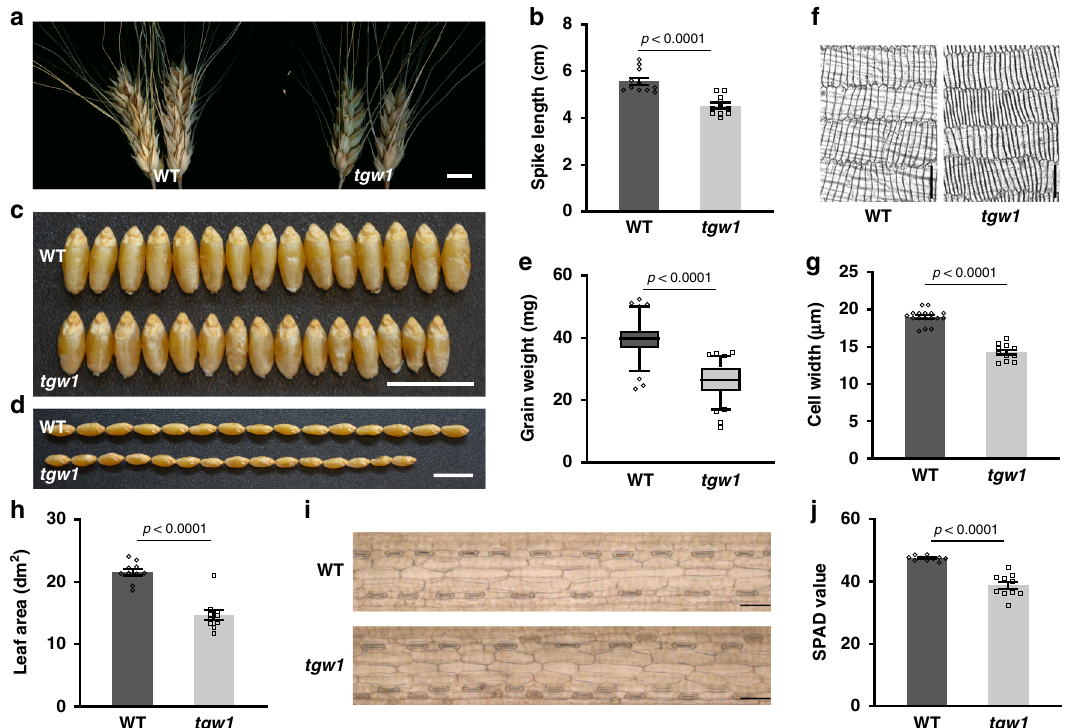
Fig. 1 Identi fi cation and characterization of tgw1 . a Representative images of main tiller spikes from WT or tgw1 . Scale bar = 1 cm. b Average length of main spikes from WT and tgw1 . n = 11. c – d Comparison of width and length of mature grains from WT or tgw1 . Scale bar = 1 cm. e Average grain weight in WT and tgw1 . n = 80. f Representative images of grain endodermal cells in WT and tgw1 . Scale bar = 100 μ m. g Average width of grain endodermal cell in WT ( n = 17) and tgw1 ( n = 11). h The average area of fl ag leaves in WT and tgw1 mutant. n = 10. i Leaf epidermal cells in WT or tgw1 mutant. Scale bar = 100 μ m. j Average chlorophyll units in fl ag leaves from WT and tgw1 mutant. n = 10. Data in e are represented as boxplots. The boxplots indicate median (middle line), 25 th , 75 th percentile (box), and 5 th and 95 th percentile (whiskers) as well as outliers (single points). Data in b , e , g , h , and j are represented as mean ± SEM, and p values are indicated by two-tailed unpaired t test. Results in f and i are representative of three independent samples. Source data are provided as a Source Data fi